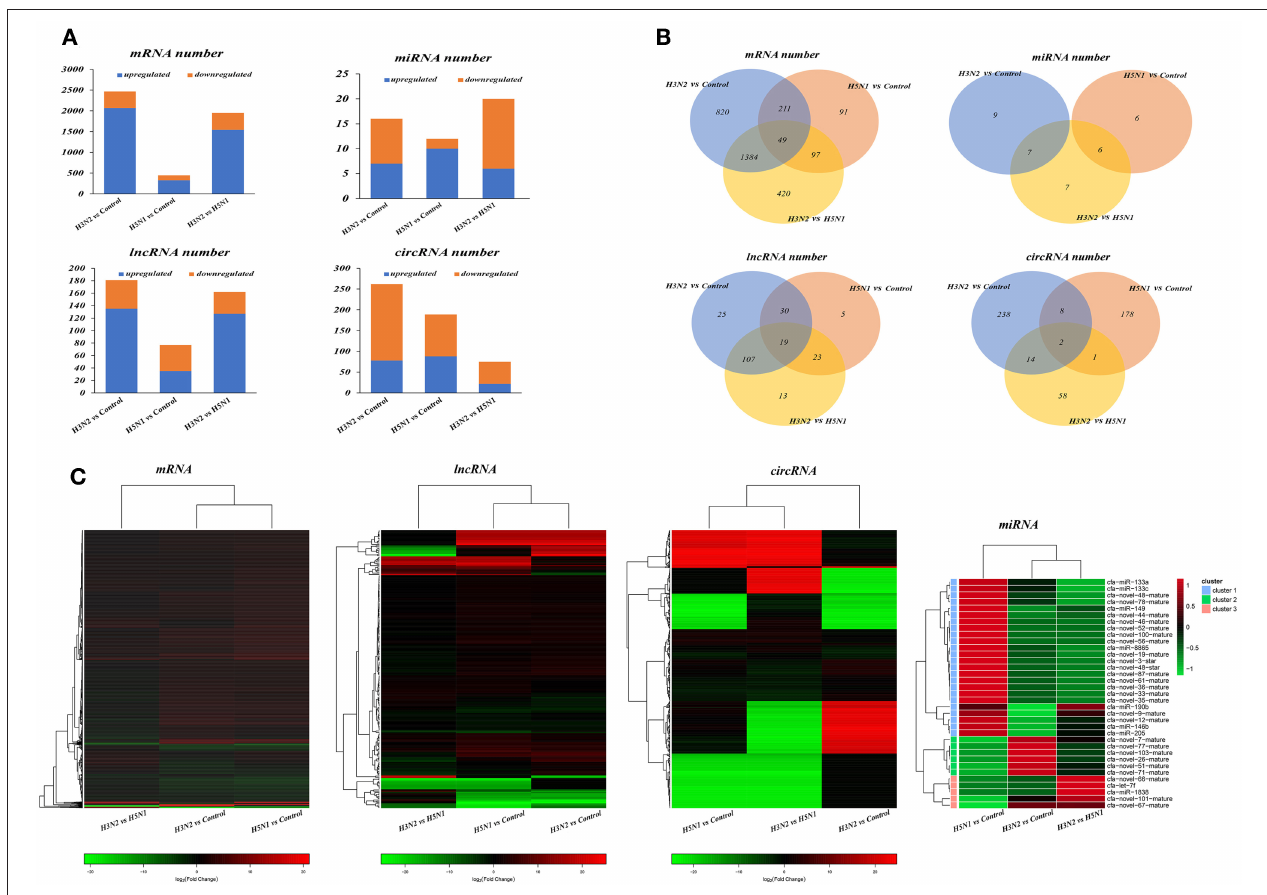
FIGURE 2 | (A) Statistical histogram of the differential expression analysis. The horizontal axis represents the comparison and the vertical axis shows the number of differentially expressed transcripts. Orange represents downregulated transcripts, and blue represents upregulated transcripts. (B) Differentially expressed transcripts. In the Venn diagram, different comparison groups are represented by different colors. The numbers in the figure represent specific or common differences in the number of transcripts. The overlapping areas represent the number of differentially expressed transcripts shared by different comparison groups; the non-overlapping areas represent the number of differentially expressed transcripts that were unique to the different comparison groups. (C) Heat map of differentially expressed transcripts based on fold changes. Each row represents a transcript and each column represents a comparison group. Red indicates upregulated expression, and green indicates downregulated